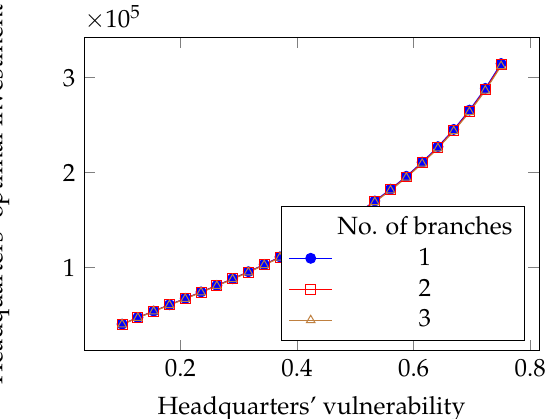
Figure 11. Impact of the intrinsic vulnerability on the optimal investment in the limited liability case.